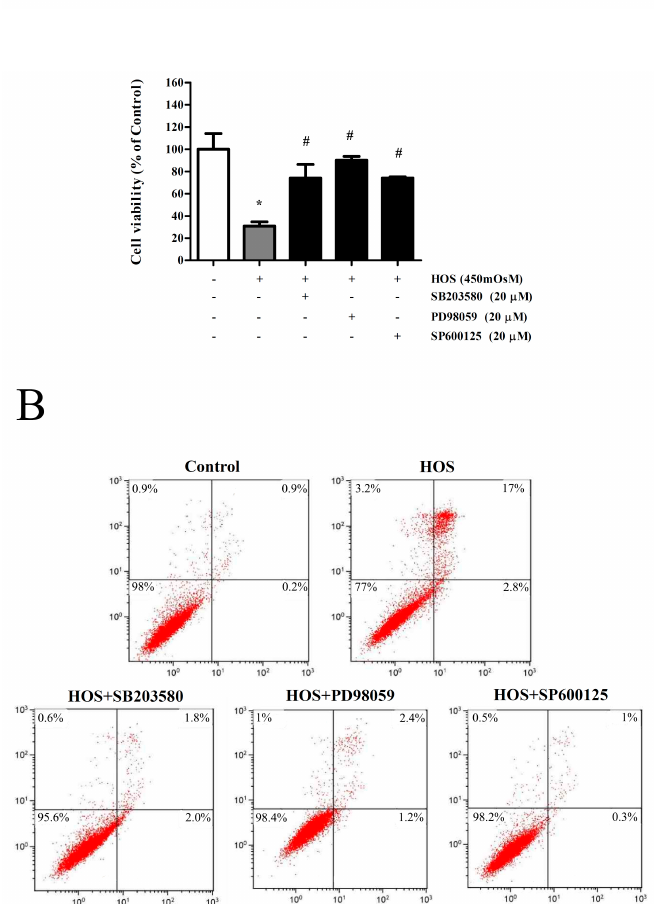
Figure 5. Effect of KIOM-2015EW on MAPK blockade on HOS-induced apoptosis. HOS-exposed